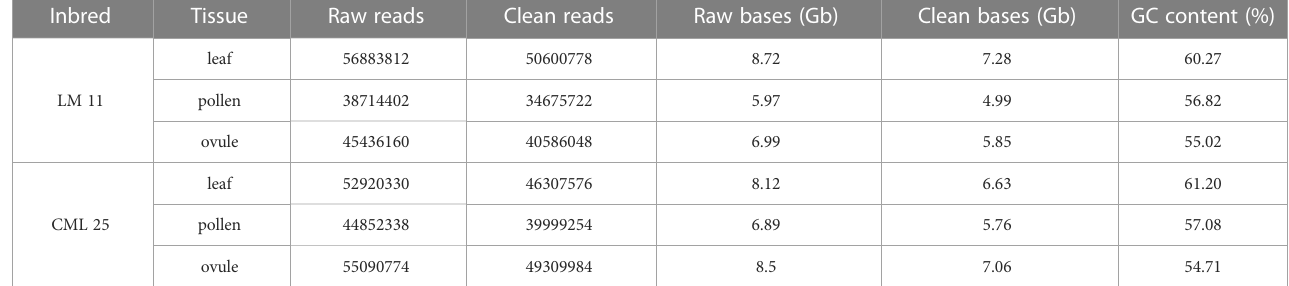
TABLE 1 Statistics of RNA-seq data obtained from three tissues of LM 11 and CML 25 inbreds under heat stress at reproductive phase.